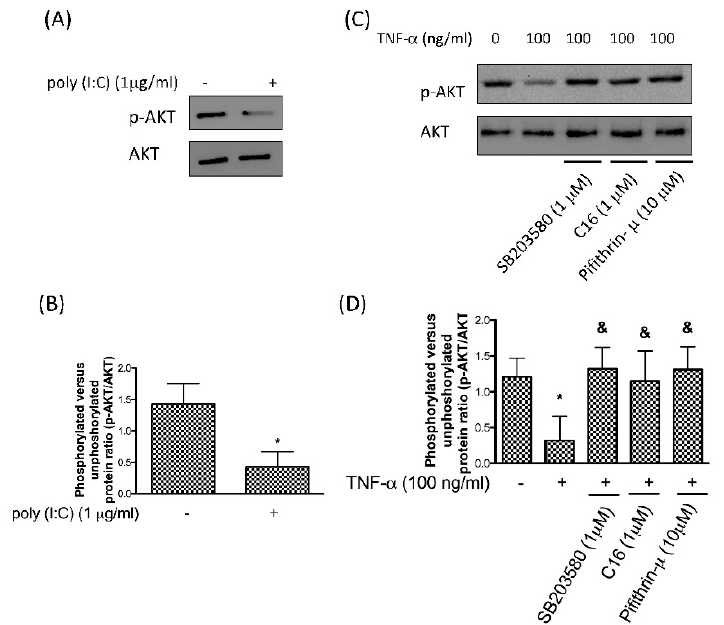
Figure 3. Protein expression ( A ) and the ratio ( B ) of p-AKT after activation of PKR using poly (I:C); protein expression ( C ) and the ratio ( D ) of p-p53 after stimulation of TNF- α in human chondrocytes in the presence or absence of p38 inhibitor SB203580, PKR inhibitor C16 or p53 inhibitor Pifithrin- µ . n = 3; * p < 0.05 compared to control group. p < 0.05 compared to TNF- α group, p values were generated by ANOVA using the Tukey’s